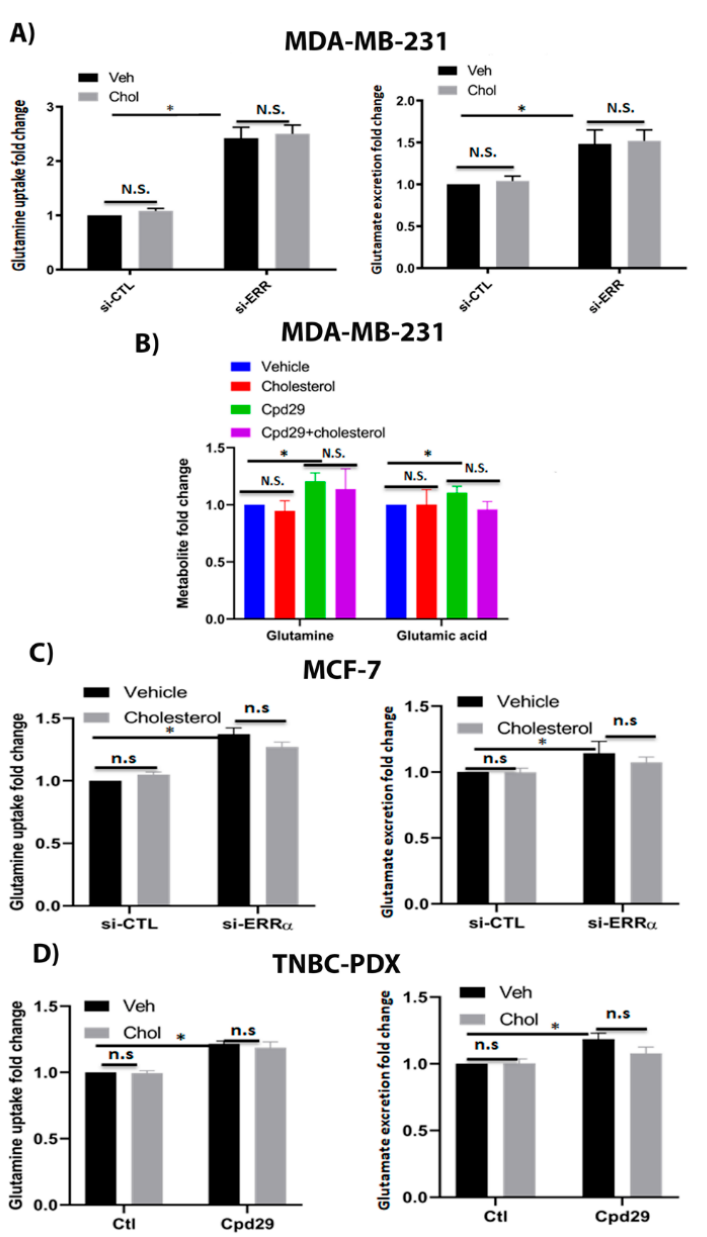
Figure 4. Cholesterol does not alter the glutaminolysis metabolite levels in breast cancer cells. ( A ) The glutamine uptake and glutamate and ammonium production were measured using a Profile 400 analyzer. MDA-MB-231 cells were transfected with siRNA-control (si-CTL) or siRNA-ERR α (si-ERR α ) and then treated with vehicle (Veh) or cholesterol (Chol, 5 µ M) for 24 h. ( B ) The metabolite levels were measured using GC/MS. MDA-MB-231 cells were treated with vehicle (Veh), cholesterol (Chol, 5 µ M), and/or cpd29 (5 µ M) for 48 h. ( C ) MCF-7 cells were transfected with siRNA-control (si-CTL) or siRNA-ERR α (si-ERR α ) and then treated with vehicle (Veh) or cholesterol (Chol, 10 µ M) for 24 h. ( D ) TNBC-PDX cells were treated with vehicle (Veh), cholesterol (Chol, 10 µ M), and/or cpd29 (10 µ M) for 48 h. Ctl (control) represents the breast cancer cells treated with cholesterol or vehicle. The results represent three independent experiments. A value of p < 0.05 was considered significant (*). N.S./n.s. = not significant.